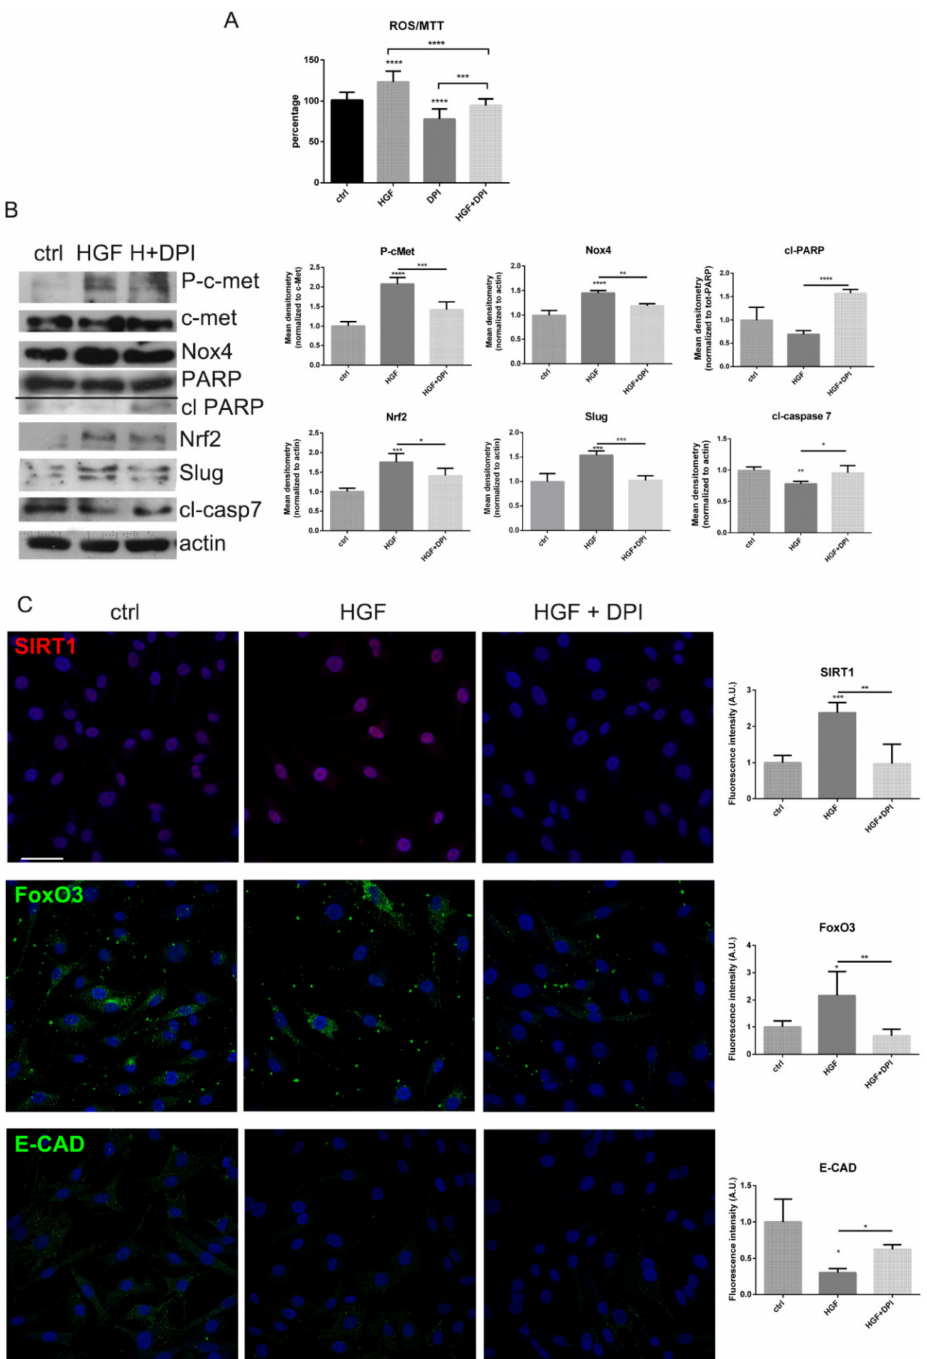
Figure 4. Nox4 and c-met modulation in SK-MEL-28 cells. ( A ) Graph showing ROS levels normalized to MTT values of measured in SK-MEL-28 cells treated with DPI up to 1 µ M for 6 h in the presence or absence of HGF. *** p- value < 0.001; **** p- value < 0.0001. ( B ) Western blot analysis of total lysate of SK-MEL-28 cells treated or not with DPI in the presence of HGF, then revealed with anti- p -c-met, anti-c-met, anti- PARP, anti-Nox4, anti-Nrf2, anti-Slug, anti-cleaved caspase 7, and anti-actin as a loading control. The graphs represent the mean ± SD of densitometric analysis of three experiments, normalized to actin or c-met or total PARP values. * p- value < 0.05; ** p- value < 0.01; *** p- value < 0.001; **** p- value < 0.0001. ( C ) Representative images with DAPI (blue), FoxO3 or E-CAD (green) or SIRT1 (red) signals of SK-MEL-28 treated as previously reported. Scale bar = 20 µ m. Fluorescence intensity of cells visualized in 5 fields for each condition are shown in the graphs. * p -value < 0.05; ** p- value < 0.01; *** p- value <